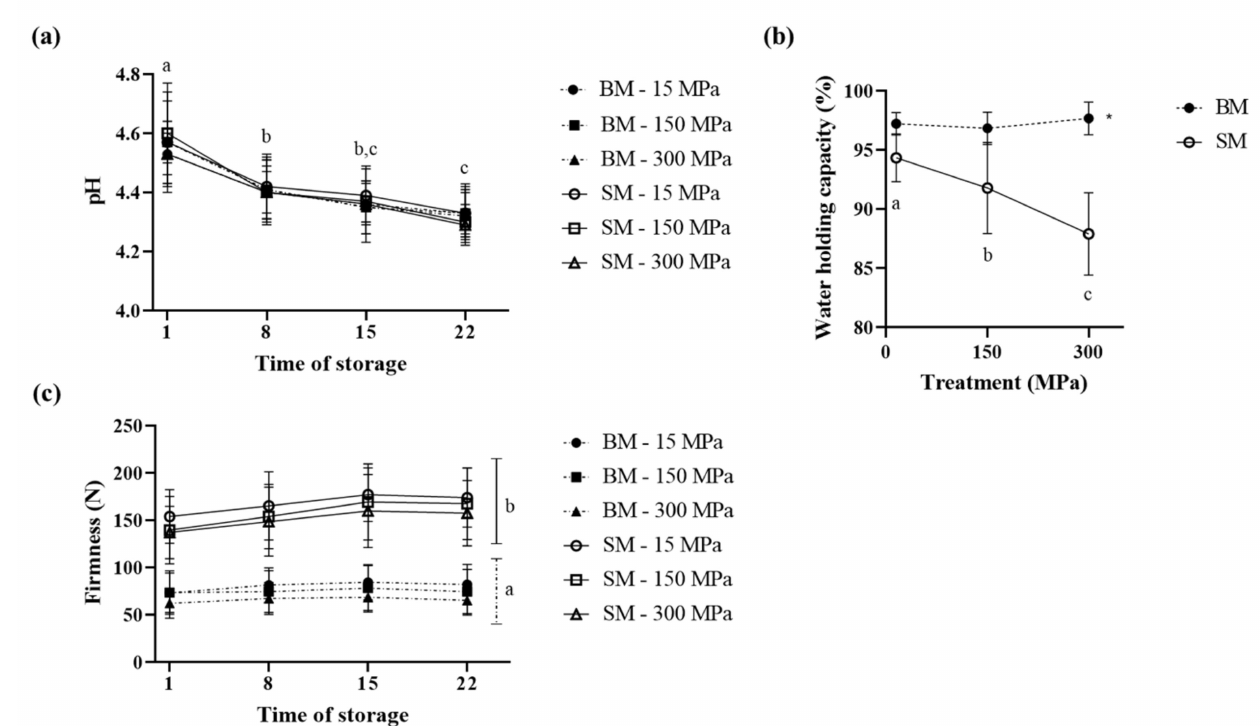
Figure 3. Evolution of physico-chemical properties (( a ) pH, ( b ) water-holding capacity-WHC, and ( c ) firmness) for set buttermilk (BM-stippled line) and skimmed milk (SM-plain line) yogurts as a function of time of storage (1, 8, 15, and 22 days) and pressure levels (15, 150, and 300